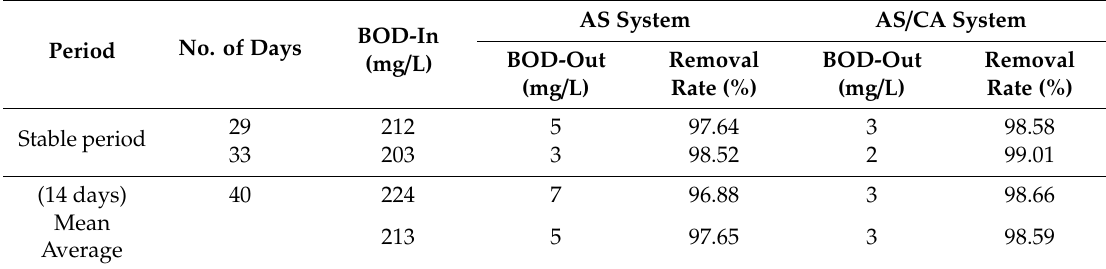
Table 6. BOD of synthetic domestic sewage treated using AS system and AS / CA system.